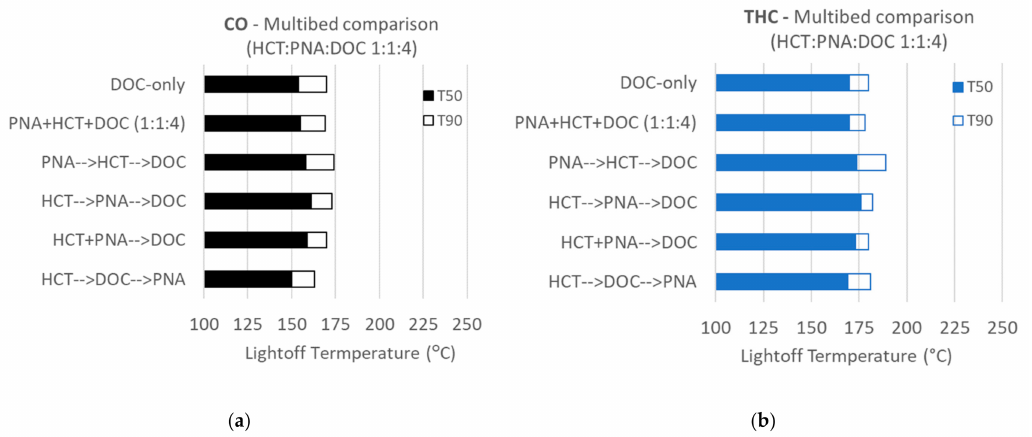
Figure 7. Inlet temperatures associated with 50% and 90% conversion (T50 and T90, respectively) for ( a ) CO and ( b ) THC over several multibed reactor